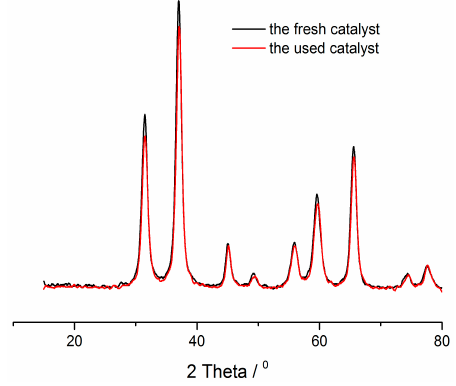
Figure 3. X ‐ ray diffractograms of the fresh catalyst and used catalyst.